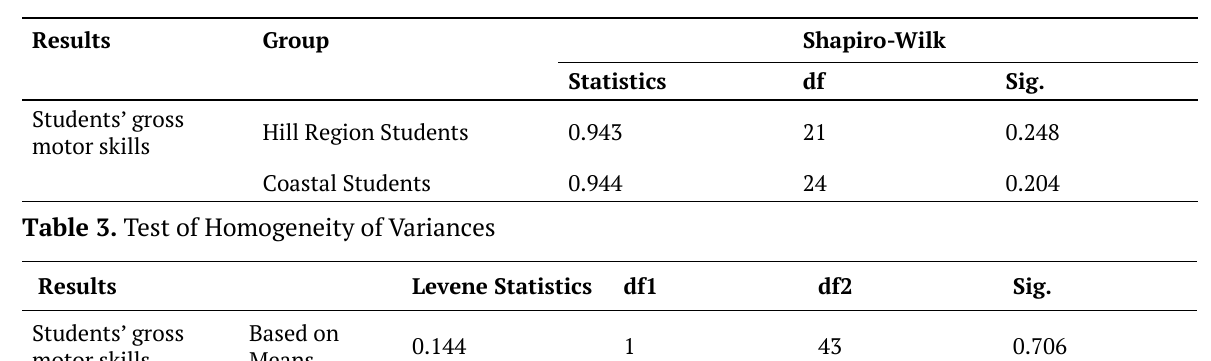
Table 2. Shapiro-Wilk Normality Test